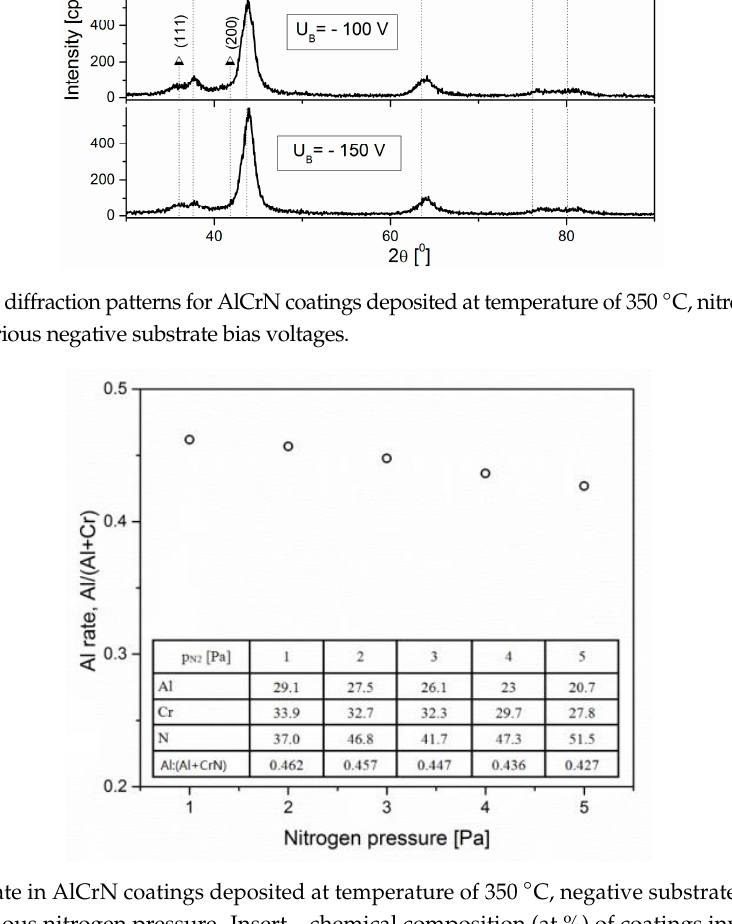
Figure 5. Al rate in AlCrN coatings deposited at temperature of 350 °C, negative substrate bias voltage 100 V and various nitrogen pressure. Insert—chemical composition (at.%) of coatings investigated.